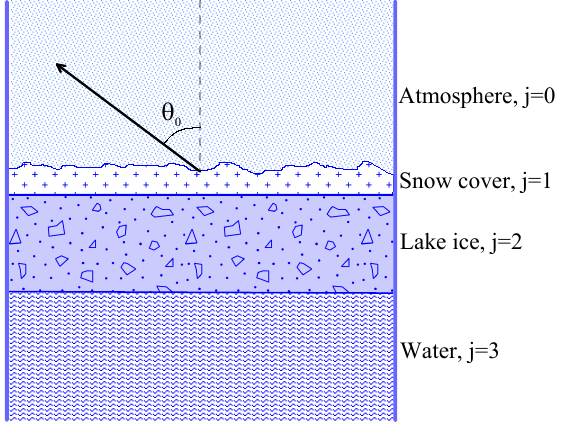
Figure 6. Model of the “water–lake ice–snow cover–atmosphere” radiating system.